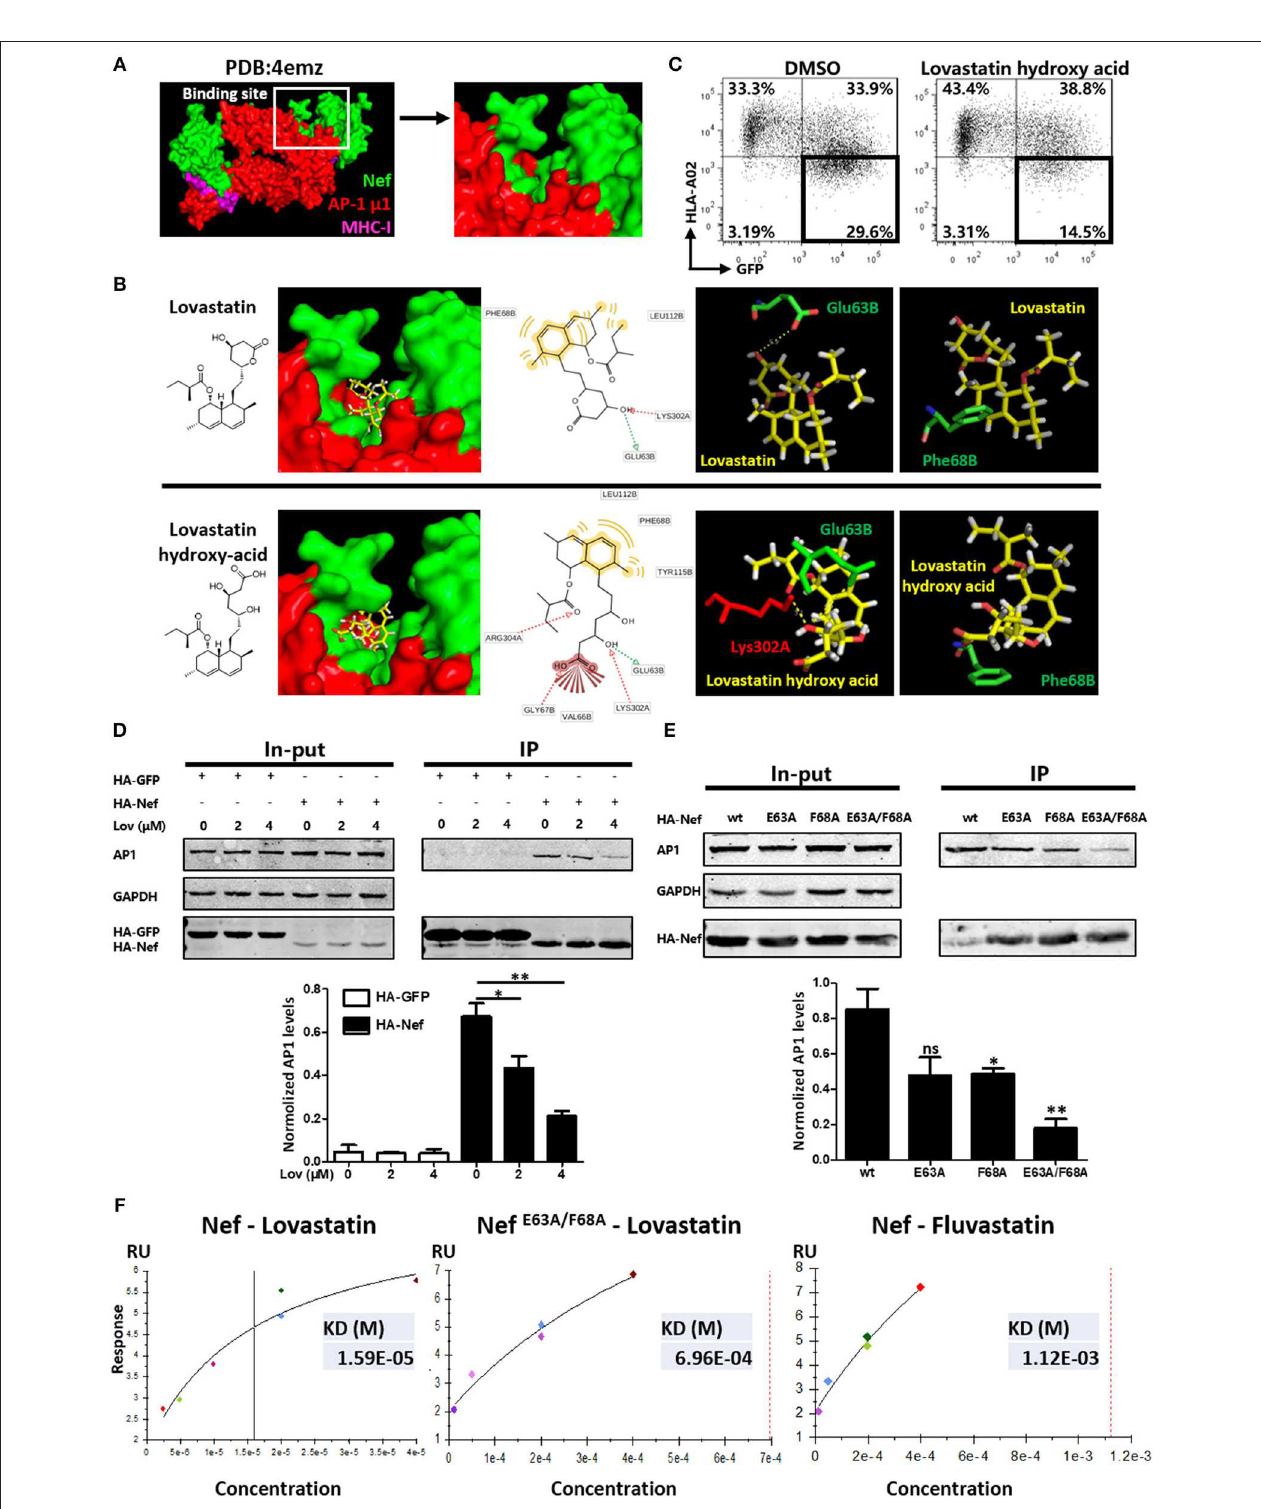
FIGURE 7 | Lovastatin directly targets Nef and inhibits the interaction between Nef and AP-1. Molecular docking studies were performed to explore the binding modes of lovastatin or its hydroxy acid form with the crystal structure of Nef in complex with of AP-1 µ 1 subunit and MHC-I cytoplasmic domain (PDB:4emz), the B and C chains in green belong to HIV Nef, the A and M chains in red belong to AP-1, and the D and E chains in purple belongs to MHC-I (A) . The pose of lovastatin or